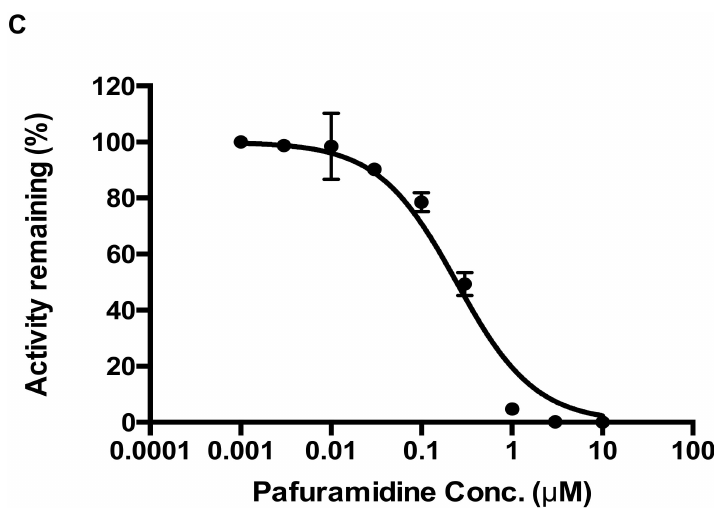
Figure 6. Inhibition of CYP4F2-mediated metabolism of Compound- 3 . ( A ) Inhibition of Compound- 3 metabolism in HLM by various chemical inhibitors; ( B ) Inhibitory effect of Compound- 3 on the metabolism of pafuramidine (1.5 µ M) mediated by CYP4F2 (10 nM); ( C ) Inhibitory effect of pafuramidine on the metabolism of Compound- 3 (1 µ M) mediated by CYP4F2 (10 nM). Data were average values of three separate